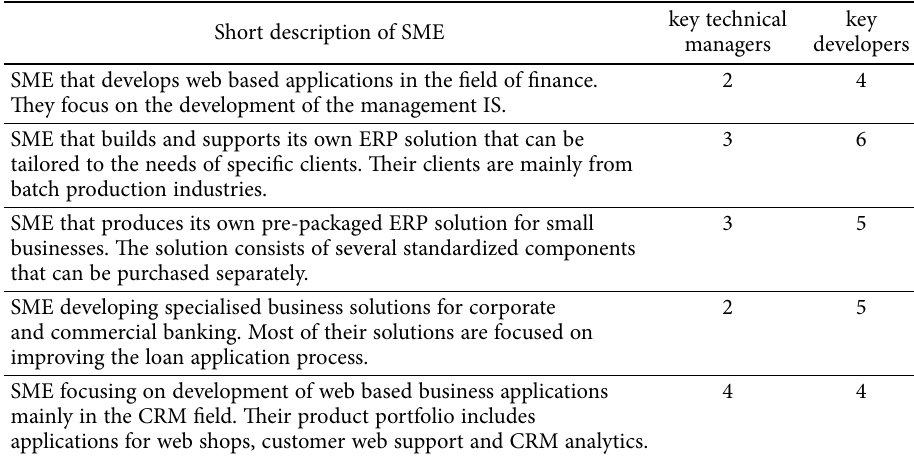
Table 1. The details of the participating enterprises and the number of interviewees Short description of